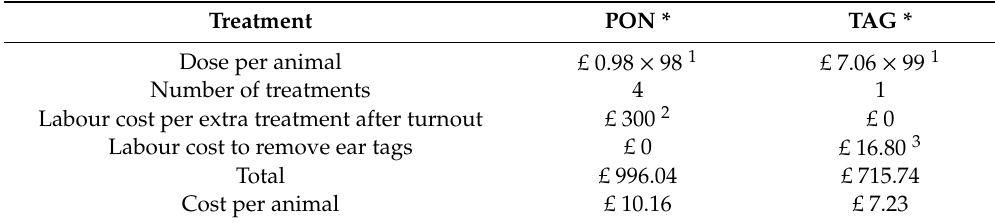
Table 4. Direct costs involved for both treatment groups in the